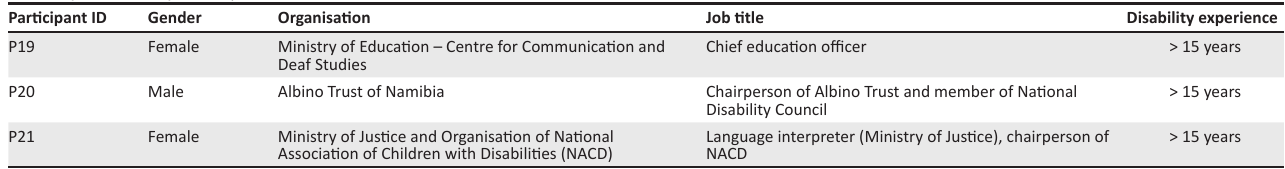
TABLE 1(Continues...): Participants’